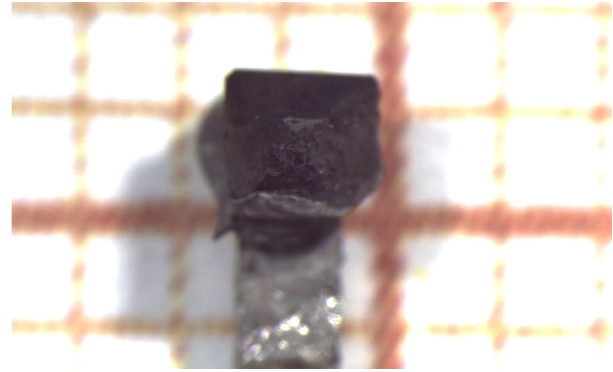
FIG. 8. Topviewofthe α -MnSsample(black)gluedontoastainless steel pin. The size of the mesh in the background is 1 × 1